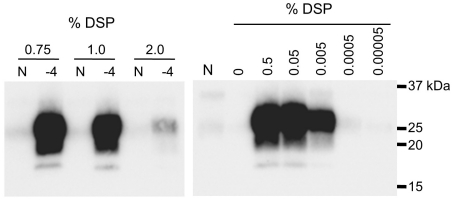
Optimal DSP concentration for BSE PrPSc amplification.The PrPSc seed was diluted to 10−4, and amplification was performed in the presence of the potassium dextran sulfate (DSP). “N” designates the control in which only PrPC substrate was amplified.